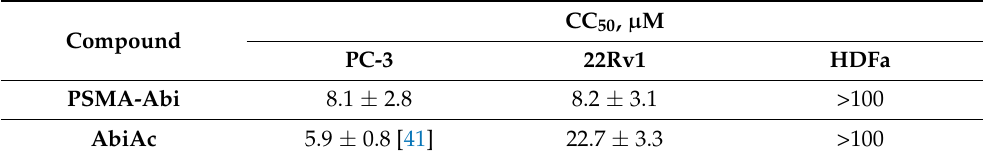
Table 1. Cytotoxicity of conjugate PSMA-Abi in comparison with AbiAc on 22Rv1 PC-3 and HDFa cell